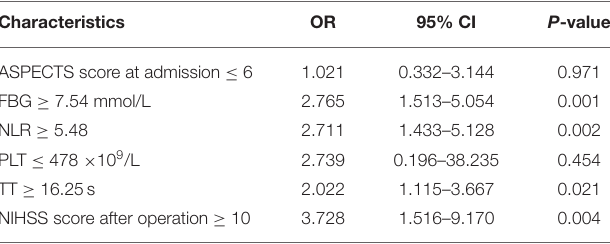
TABLE 4 | Multivariate analysis of predictors of sICH after EVT.